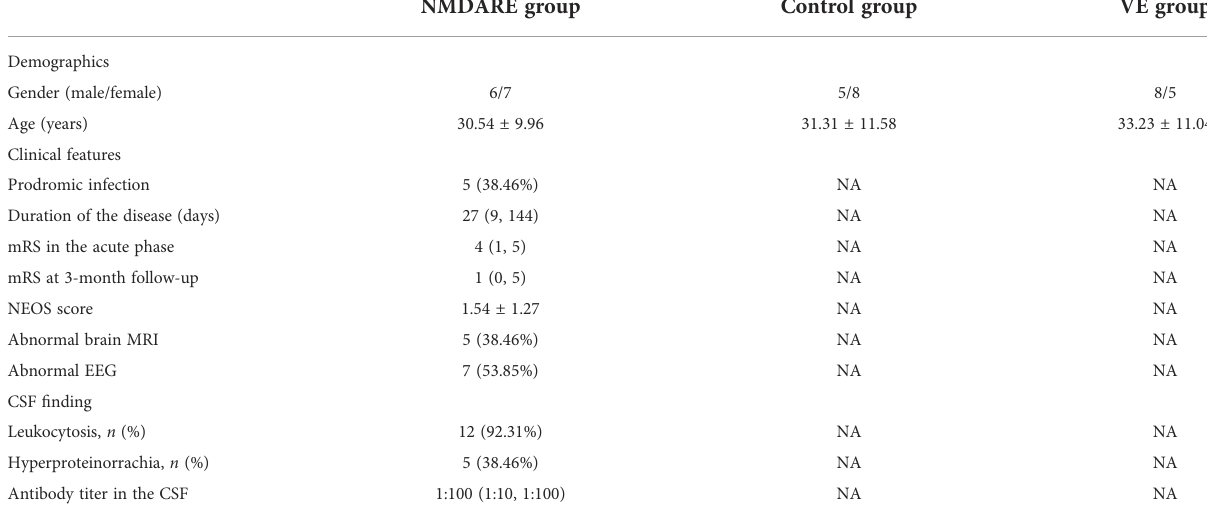
TABLE 1 Clinical characteristics of study population in cohort